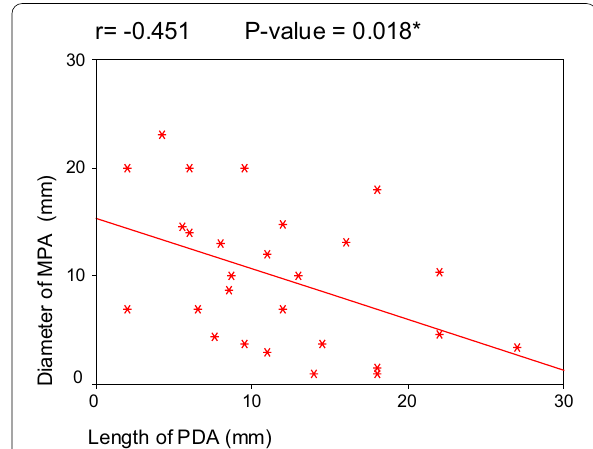
Fig. 6 Spearman’s correlation between length of PDA and diameter of MPA